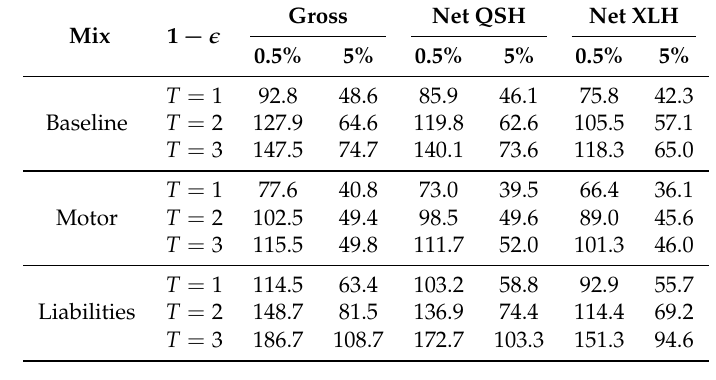
Table 13. SCR for Tau according to different T and (cid:101) (amounts in mln of Euro).